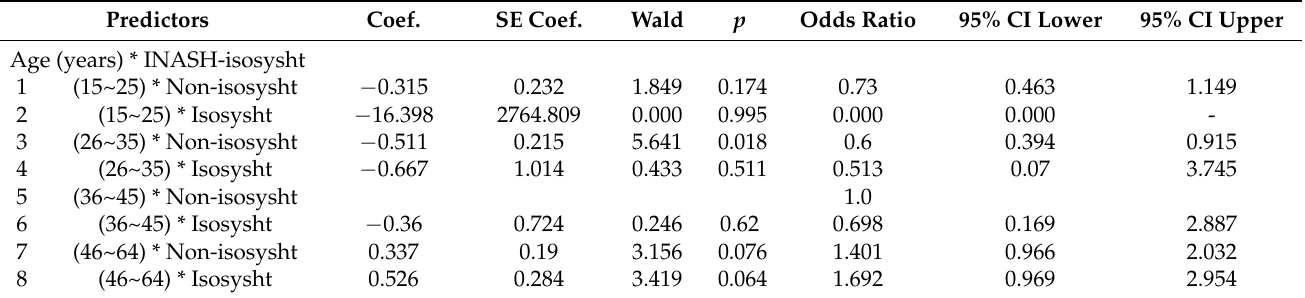
Table 4. Combination effect of age and blood pressure criteria on hearing